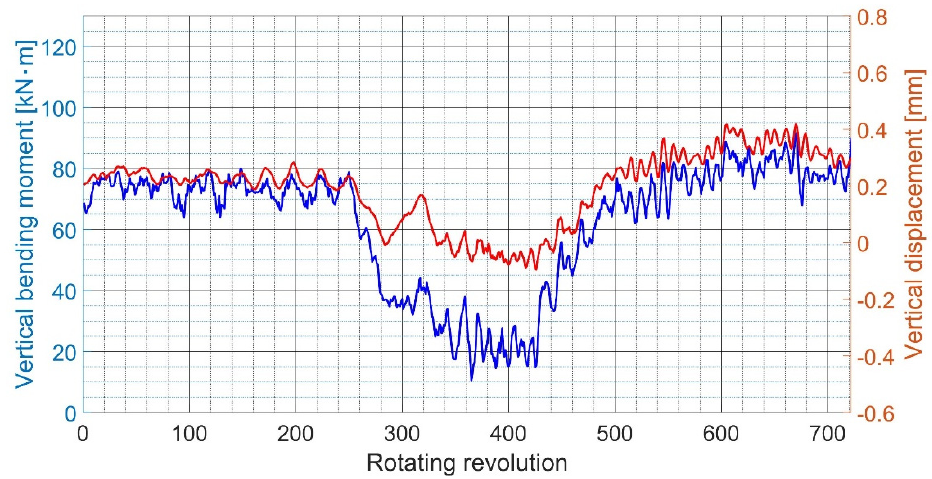
Figure 11. Bending moment and displacement behavior in the vertical direction during the port turn under the fully laden condition.